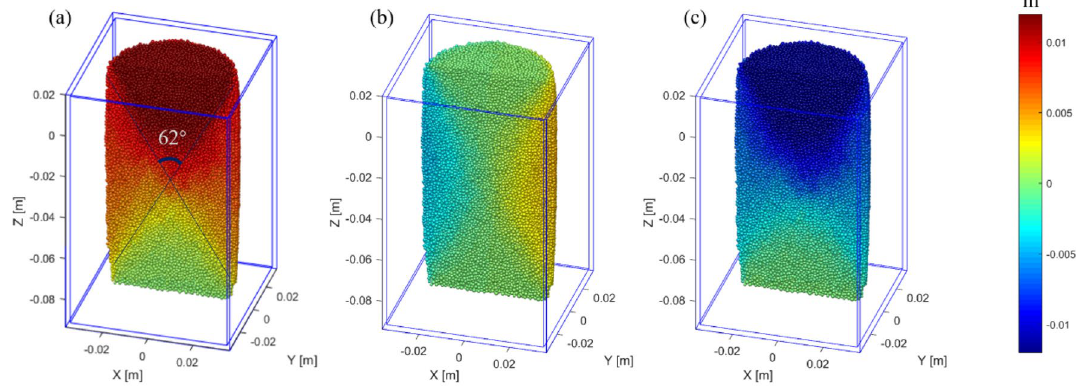
Figure 11. The displacement field at strain 8.5% under 2 MPa confining pressure: ( a ) total displacement; ( b ) X-displacement; ( c ) Z-displacement.